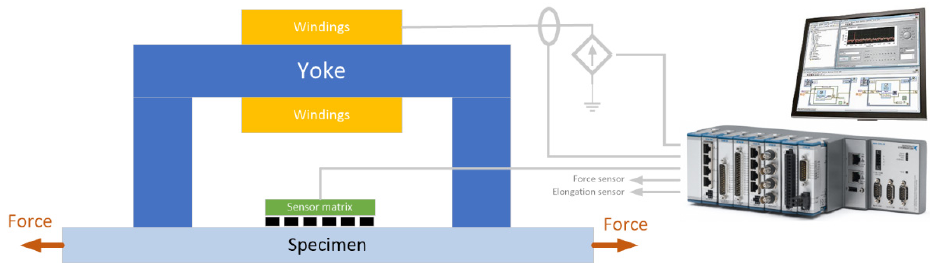
Figure 6. Diagram of the test stand for the second variant of the experiment.